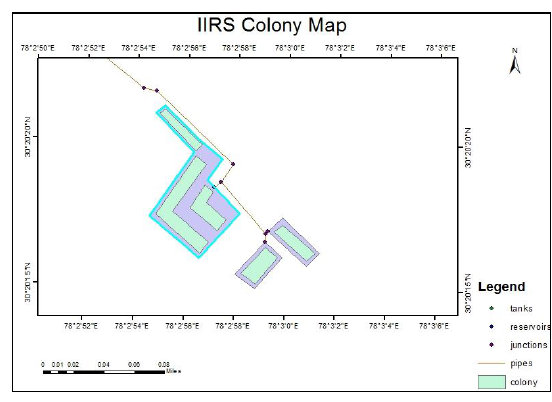
Figure 3. Future pipe network